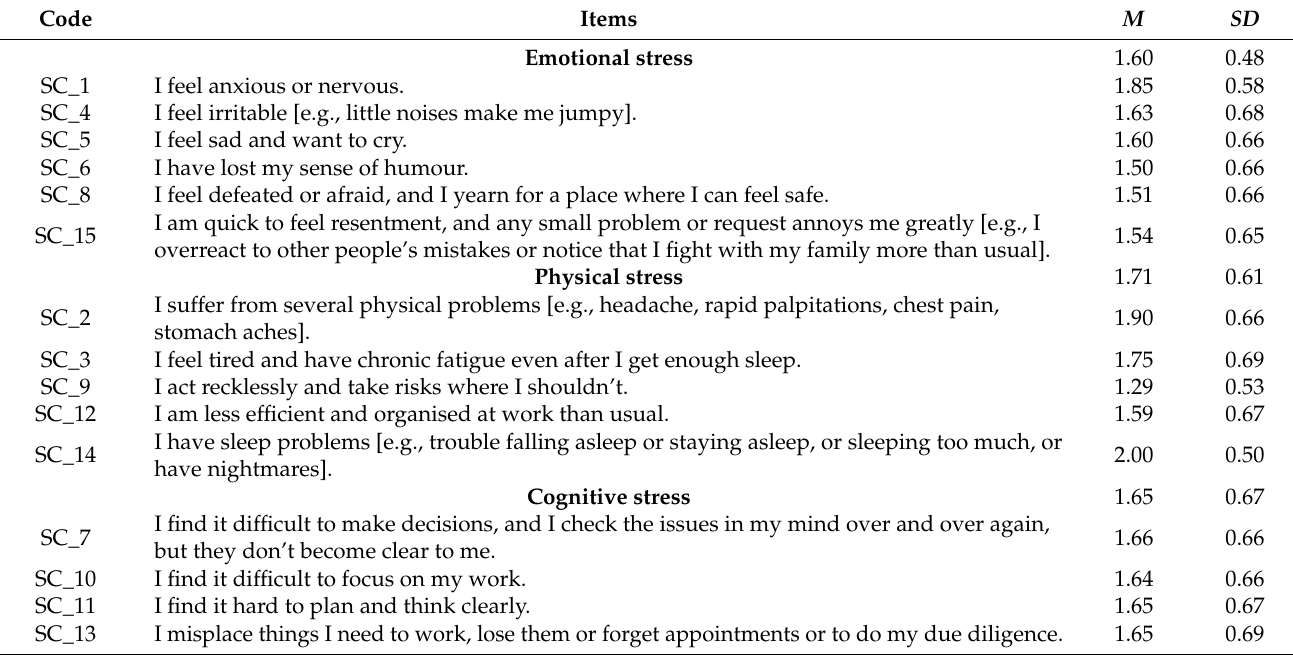
Table 1. Summary of the